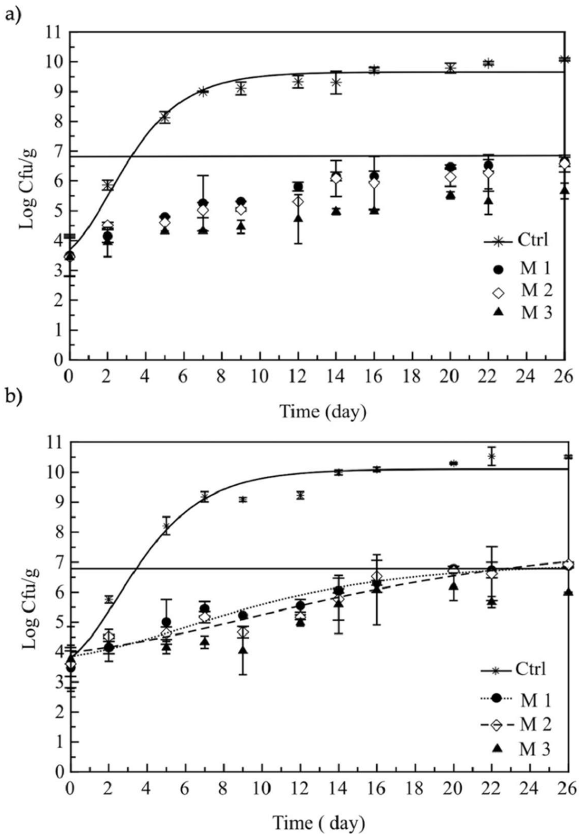
Figure 3. Evolution of total mesophilic ( a ) and psychrotrophic ( b ) bacteria in fish burgers during storage at 4 °C. Data are presented as mean ± SD. Symbols: experimental data; solid line: threshold for microbial acceptability set to 5 × 10 6 CFU/g. Ctrl: fish burger; M1: fish burger with mix of juice and re-ground pomegranate powders; M2: fish burger with mix of juice, water and re-ground pomegranate powders; M3: fish burger with mix of juice and ground pomegranate powders.